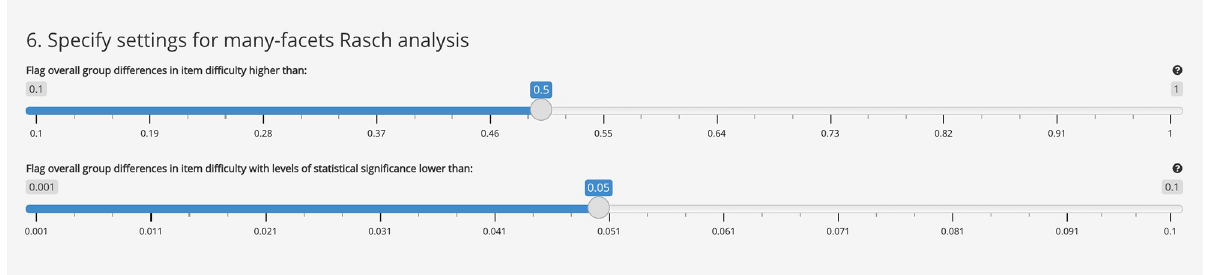
Fig 9. Additional user controls for facets